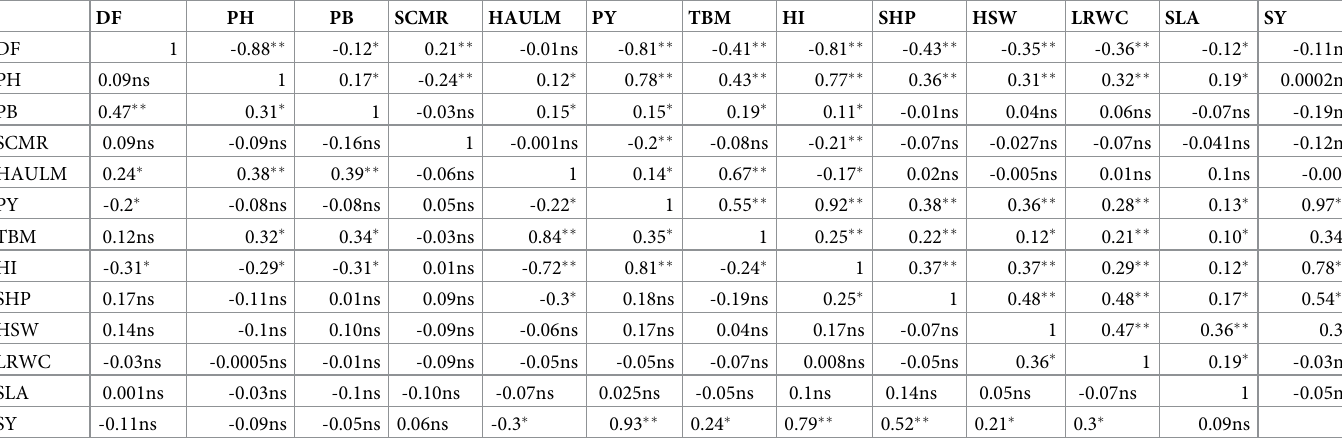
Genetic relationship among the 99 groundnut genotypes The pairwise genetic distance matrix showed 4 851 combinations among the 99 genotypes (S4 Table). The genetic distance ranged from 0.11 to 0.52, with a grand mean of 0.34. Twenty Table 3. Pearson’ s correlation coefficient (r) showing association of 13 phenotypic and physiological traits of 100 groundnut genotypes evaluated across two sea- sons evaluated under drought-stresses (upper diagonal) and non-stressed (lower diagonal) conditions.